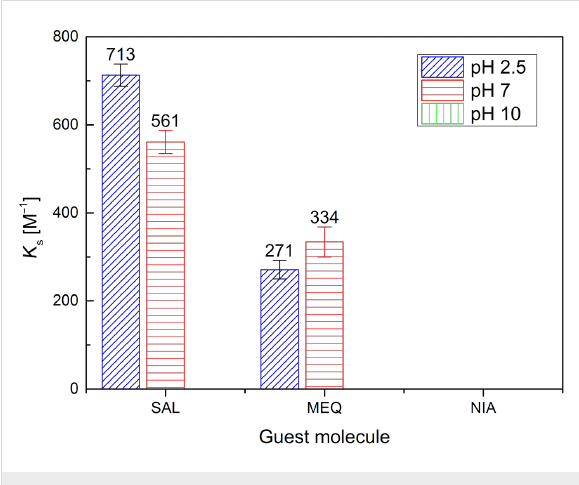
Figure 3: Stability constants for PEMPDA- β -CD with SAL, MEQ and NIA obtained by ITC